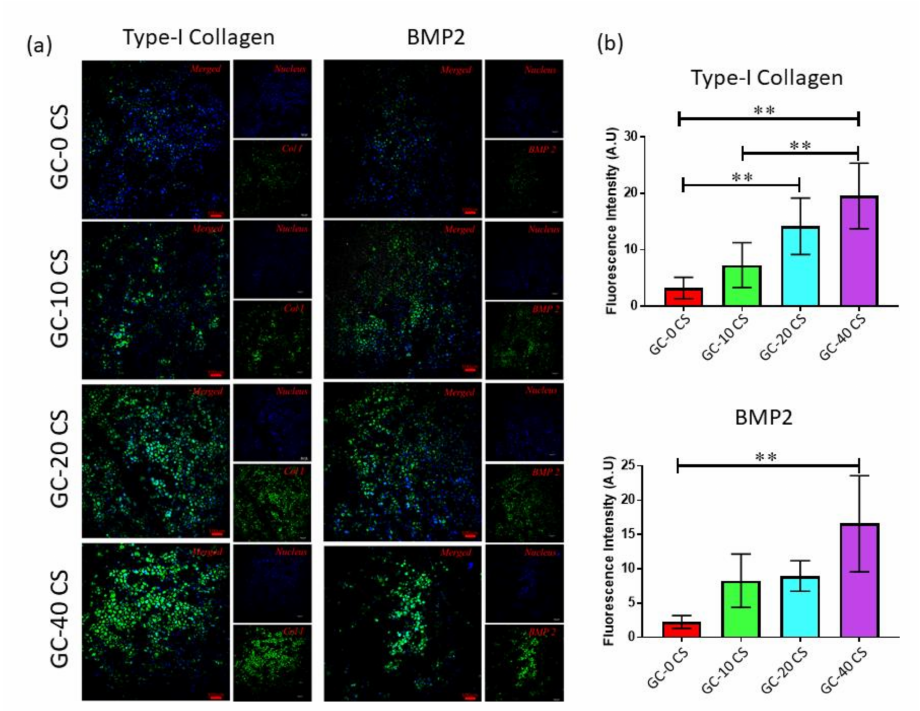
Figure 9. Osteogenic protein expression of hBMSCs seeded in GC-0 CS, GC-10 CS, GC-20 CS, and GC-40 CS scaffolds at day 7: ( a ) Type-I collagen (Col1) and BMP2 confocal images and ( b ) ImageJ semiquantitative analysis of confocal images. Statistical analyses: One-way ANOVA followed by Post-Hoc LSD test; ** p < 0.01 indicates level of statistical significance between all groups against GC-0